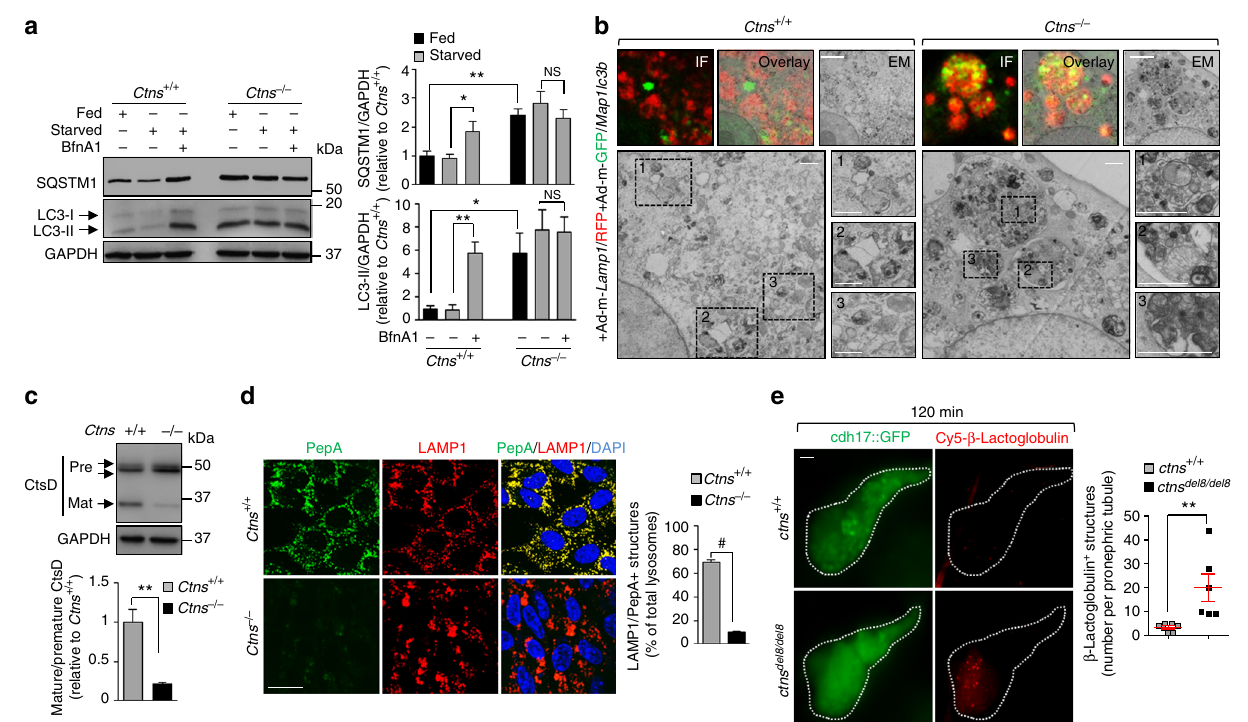
Fig. 3 Cystinosin de fi ciency delays the clearance of autophagosomes by impairing lysosome function. a Western blotting and densitometric analyses for LC3 and SQSTM1 protein levels in Ctns mPTCs cultured in fed or starved medium in the presence or in the absence of 250 nM BfnA1 for 4 h ( n = 3 independent experiments). Two-tailed unpaired Student ’ s t -test, ** P < 0.01 (SQSTM1) and * P < 0.05 (LC3) relative to fed Ctns + / + mPTCs, and * P = 0.05 (SQSTM1) and ** P = 0.009 (LC3) relative to starved Ctns + / + mPTCs. b Correlative light-electron microscopy (CLEM) in Ctns mPTCs co-transduced with and RFP-LAMP1 was monitored by confocal microscopy. Selected cells were further processed and serial sections analysed by electron microscopy. Dotted black squares contain images at higher magni fi cation. Scale bars are 2 μ m (top panel) and 500 nm (bottom panel). c Western blotting and